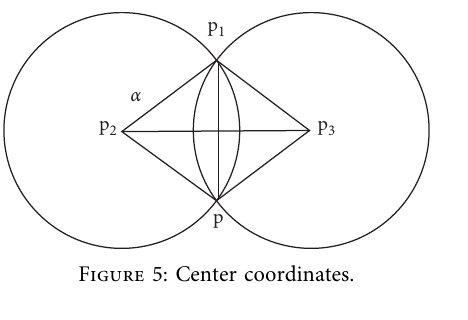
Figure 4: Alpha shapes algorithm.